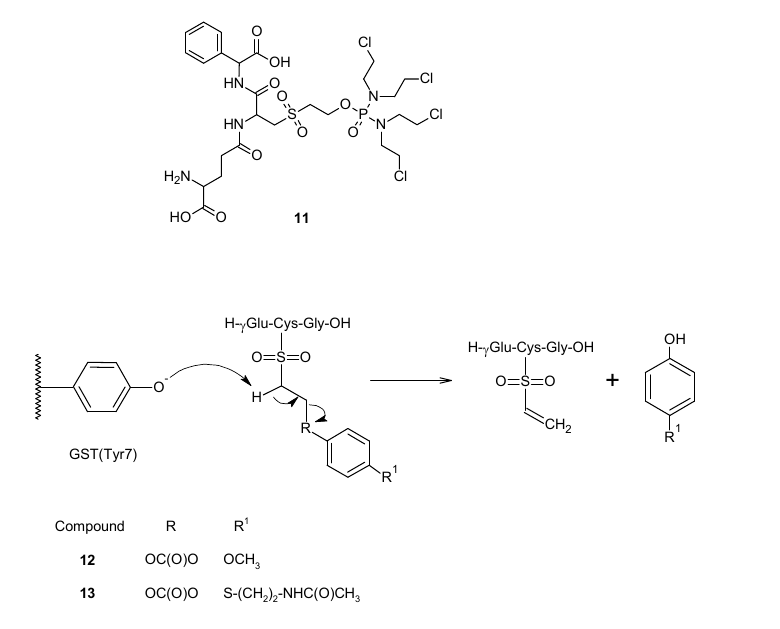
Figure 6. Chemical structure and mechanism of activation of compounds 11 , 12 and 13